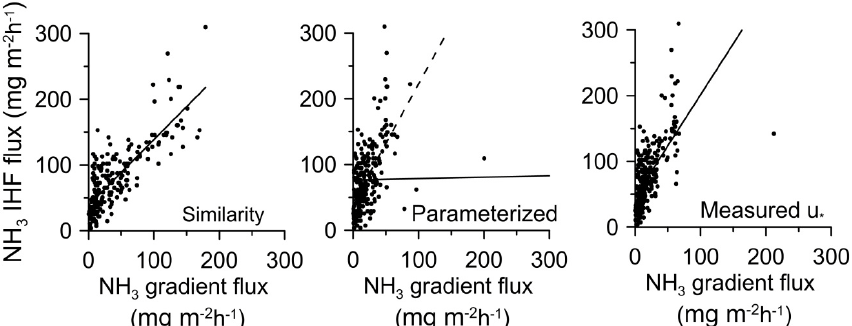
Fig. 7. The comparison between the IHF method and the flux-gradient method using K c of “similarity” approach according to Eqs. (1) and (2), of “parameterized” approach with theoretical friction velocity u ∗ and stability correction function ψ c as well as of “measured u ∗ ” approach. Linear regressions between the flux measures are indicated by solid lines. The dashed line at “parameterized” flux comparison indicates the linear regressions when outliers less than zero and greater than 200mgm − 2 h − 1 are neglected.